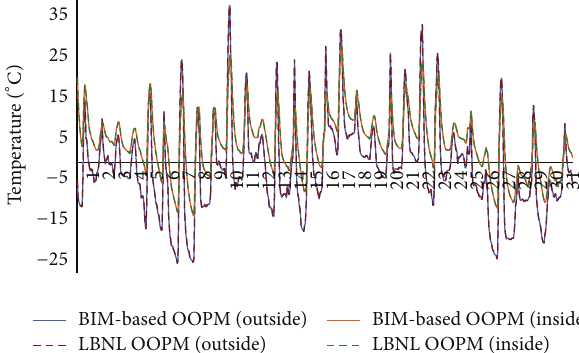
Figure16:Temperaturecomparisonbetweenthetwomodelsforthe south wall in Test Case 2 during